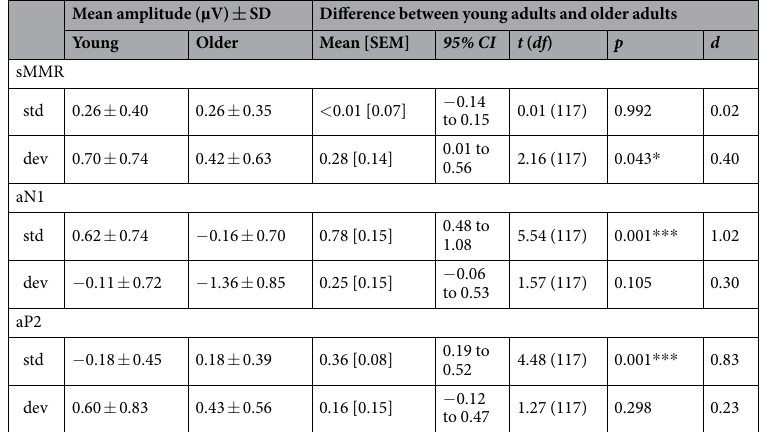
Table 3. Mean amplitude values and standard deviantions and results of the independent samples t- tests (two- tailed, bootstrapped with 1000 iterations) comparing the response amplitudes between the groups of young and older adults in the later somatosensory and auditory ERP components in response to standard and deviant stimuli. SEM, standard error of mean; SD, standard deviation; CI, confidence interval; d , Cohen’s d ; df, degrees of freedom; p , statistical significance; * p < 0.05; ** p < 0.01; *** p <